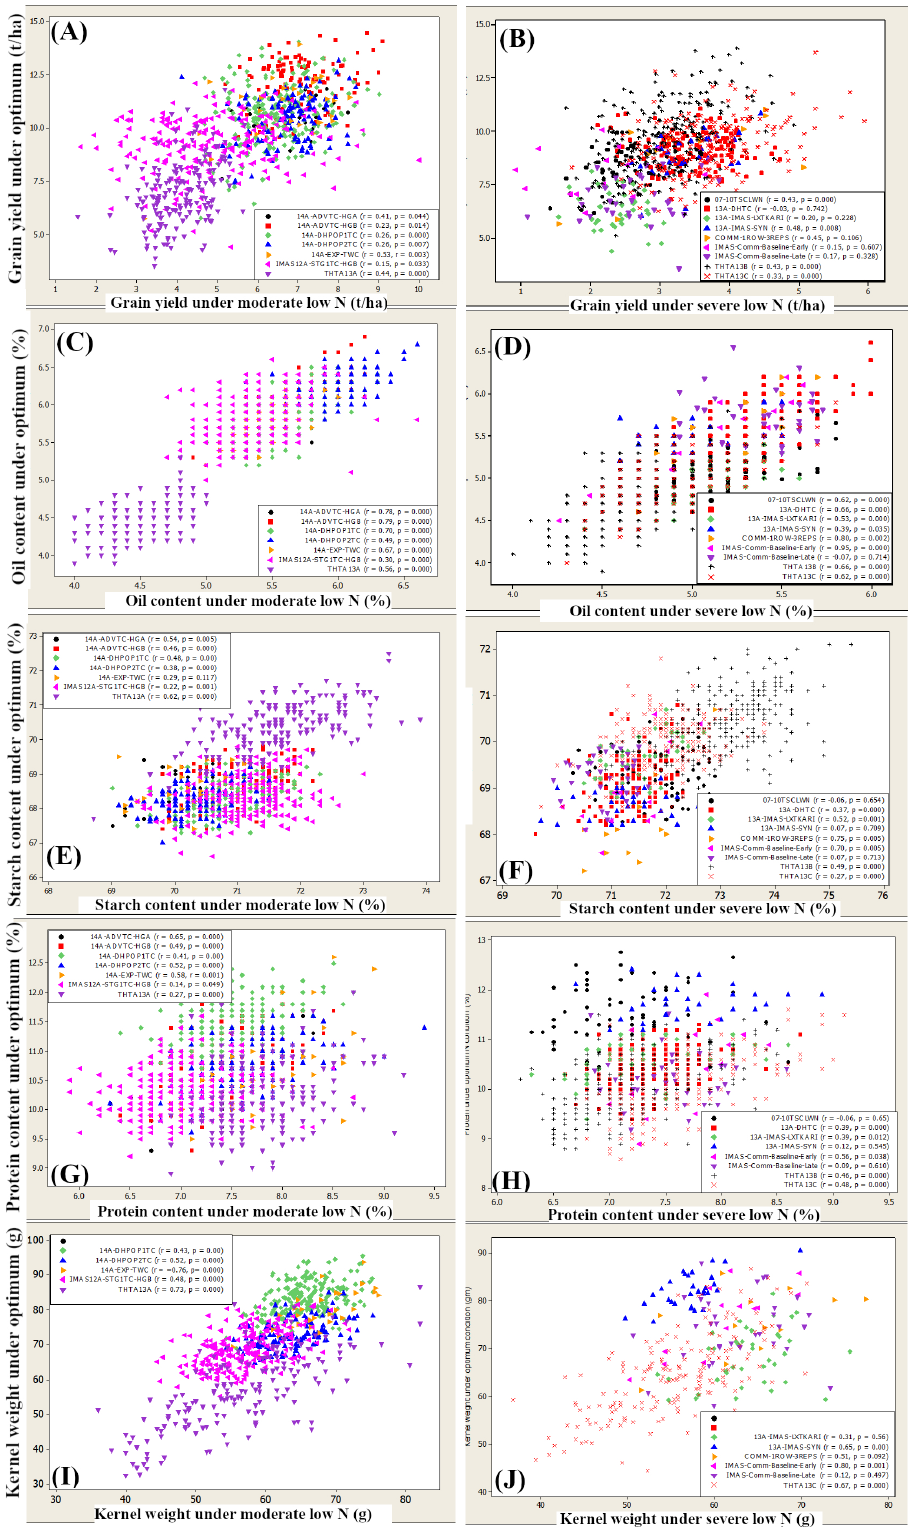
Figure 3. Relationship between optimum and stress environments (moderate and severe low-N stress) for grain yield ( A , B ), percentage of oil content ( C , D ), percentage of starch content ( E , F ), percentage of protein content ( G , H ) and kernel weight ( I , J